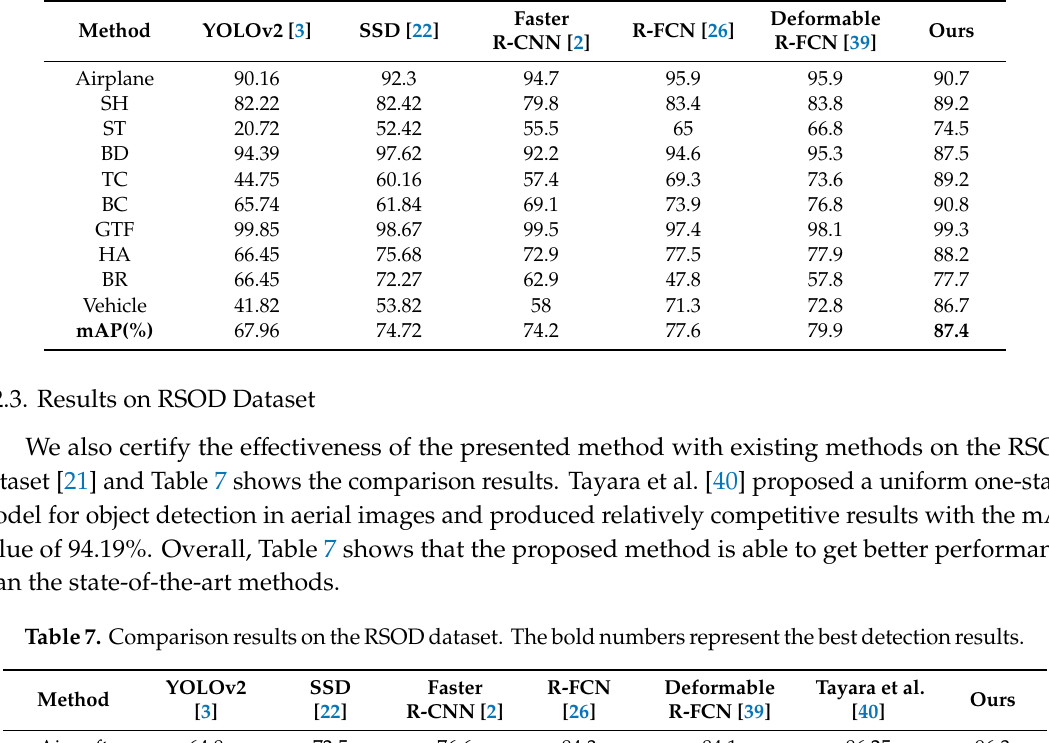
Table 6. Comparison results on the NWPU VHR-10 dataset. The abbreviation names of the category are described in detail in Section 4.1.1 and the bold numbers represent the best detection results.